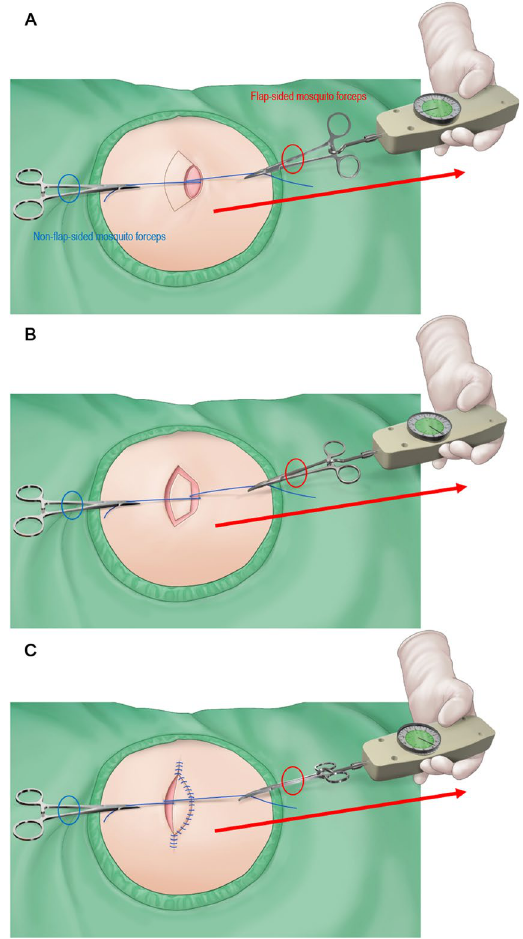
Figure 7. Schematic illustration of the procedure for intraoperative tensiometer measurement. A 3-0 (Ethilone) suture is passed through both wound edges at the most concave point (i.e., across the widest part of the defect), and a mosquito forceps is attached to each suture. The non-flap-sided forceps is kept in place without pulling because it is the only reference point for the direction of the flap-sided forceps. The flap-sided forceps is pulled apart gently until the wound edges are nearly approximated with each other. Then, the tensiometer is connected to a ring on the flap-sided mosquito forceps to record wound tension. Three consecutive measurements are performed, and the average value is used. Tensiometer is sterilised for intraoperative use. The red-coloured oval represents the flap-sided mosquito forceps, and the blue-coloured oval represents the non-flap-sided mosquito forceps. ( A ) Measurement of the ‘pre-flap tension at the defect’. ( B ) Measurement of the ‘post-flap tension at the defect’. ( C ) Measurement of the ‘post-flap tension at the